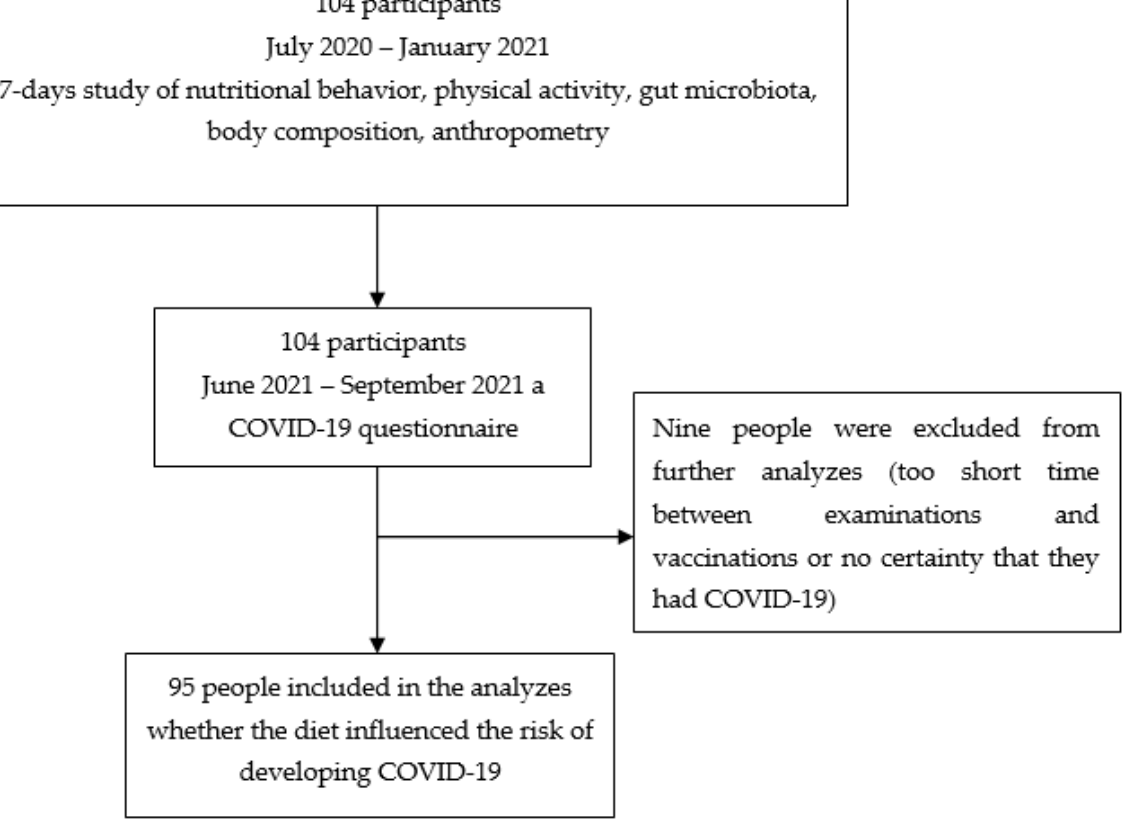
Figure 1. Selection of the study participants—own description.